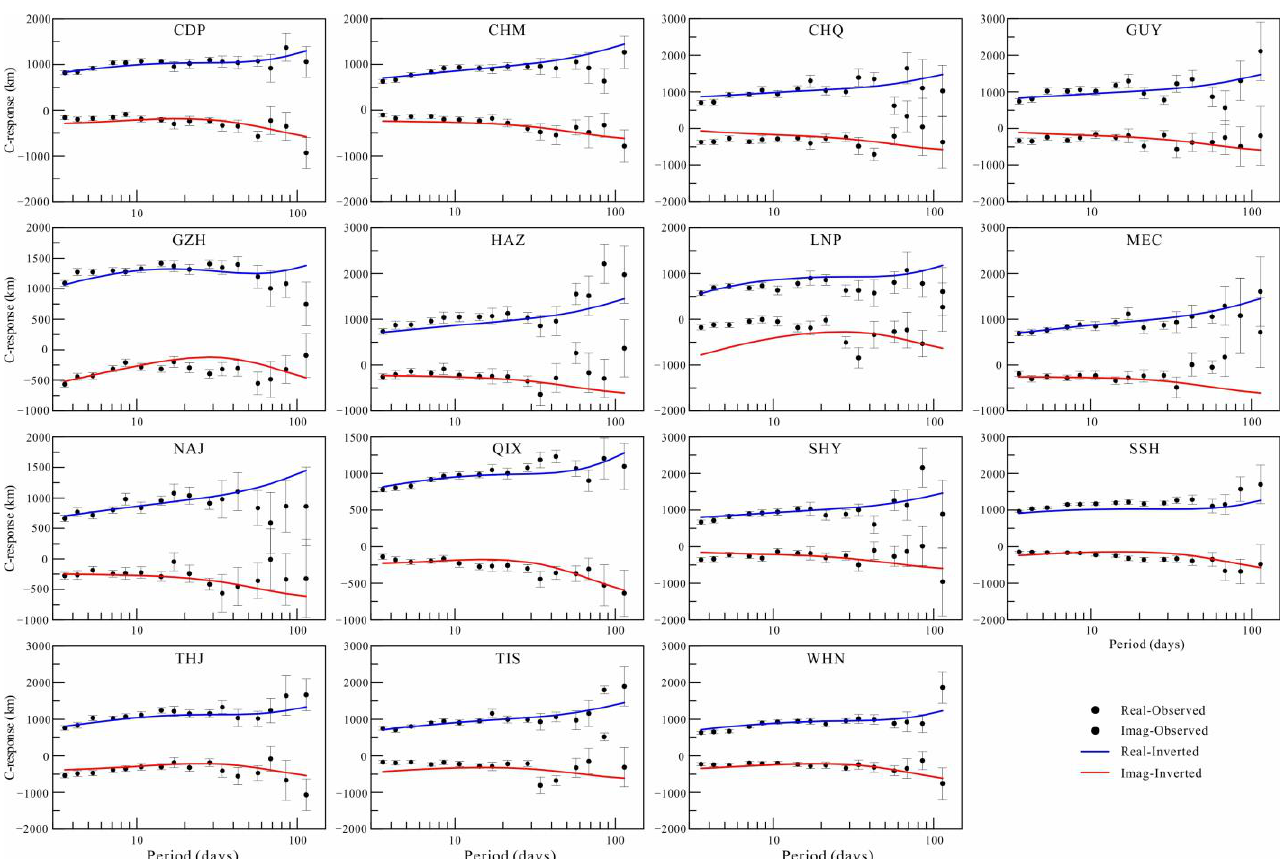
Figure 7. Fitting curves of the inverted responses and observed data.